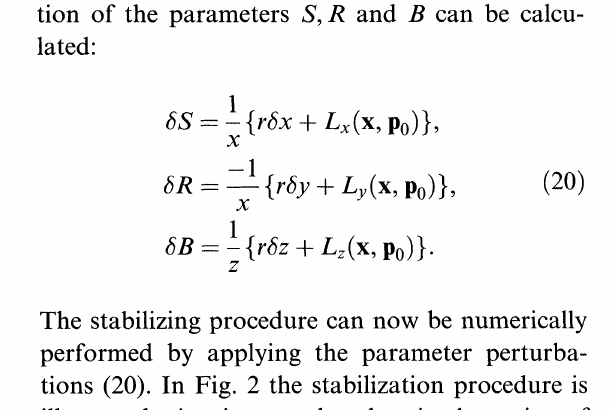
FIGURE 3 Mean values of relative maximum parametrical perturbations